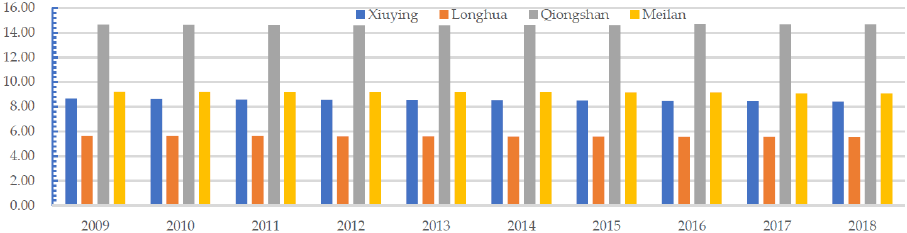
Figure 9. Changes in the eco-environmental quality index of the four districts in Haikou, China, from 2009 to 2018.